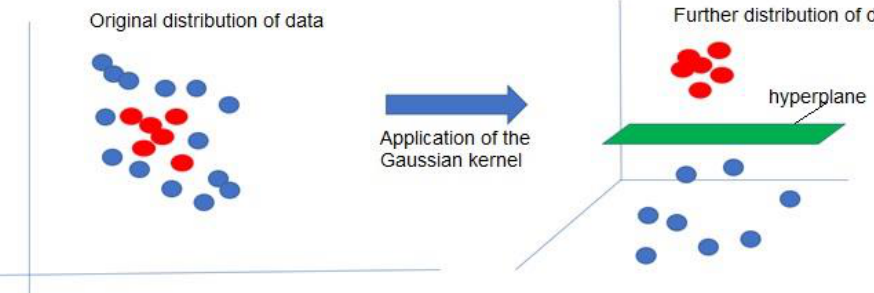
Figure 1. Graphical representation of the analysis of the distribution of variables using Gaussian kernel algorithms.